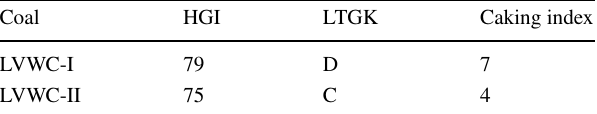
Table 3 Caking index, HGI and LTGK of LVWC